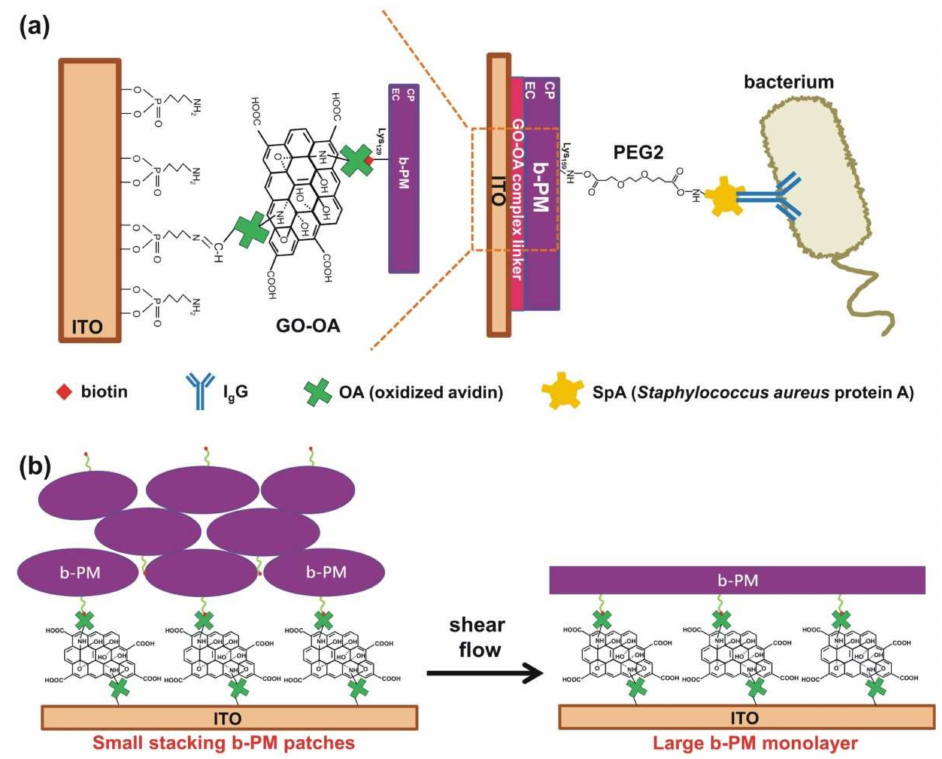
Figure 1. ( a ) Structural scheme of a SpA-based immunosensor prepared via Bis(NHS)PEG2 (right half) and structural details of linkages between b-PM and ITO (left half). IgG and PEG2 symbolize an antibody and Bis(NHS)PEG2, respectively. ( b ) Conceptual mechanism of the post-deposition washing procedure employed in the fabrication of a large b-PM monolayer on